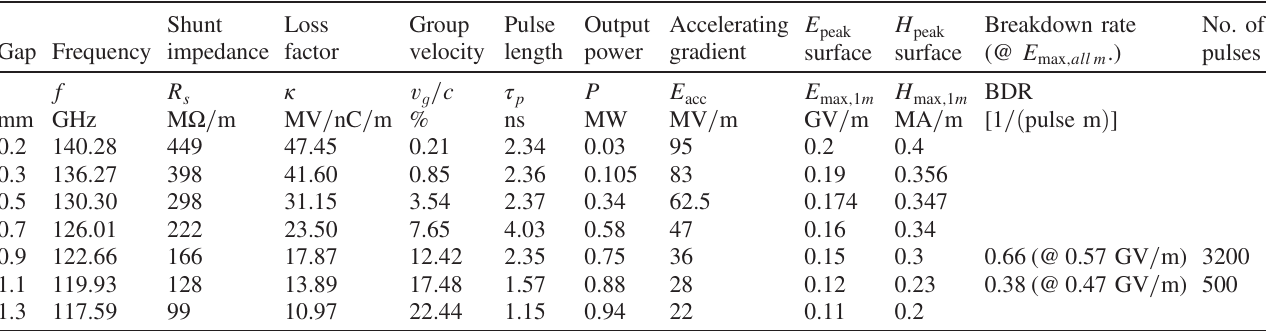
TABLE I. Radio-frequency parameters of the fundamental mode in the traveling wave copper accelerating structure. Radio-frequency fields and power are normalized to 1 nC bunch charge. The beam is on the central axis. The peak electric and magnetic fields are calculated on the surface, “ 1 m . ” means for the fundamental mode only, while “ all m . ” means the sum of all modes. Gap